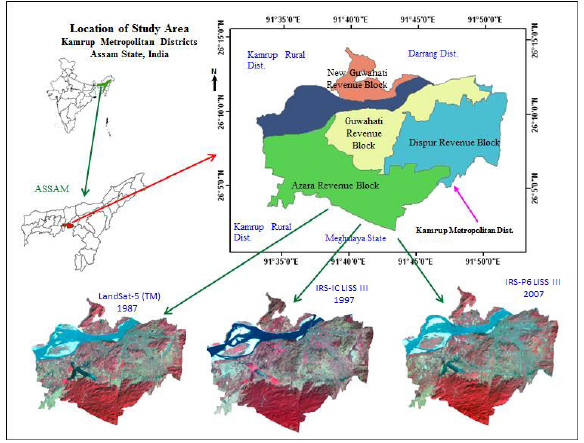
Figure 2. Location and satellite images of study